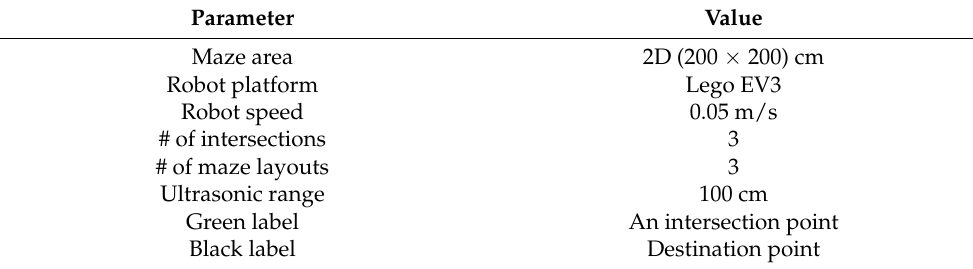
Table 5. Several parameters for the experiment.